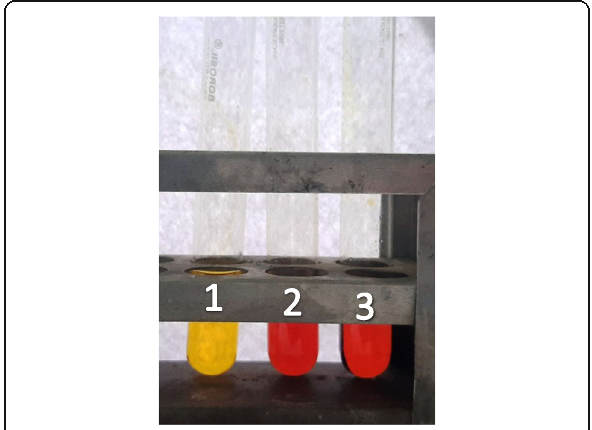
Fig. 7 Qualitative analysis of reducing sugar by DNS assay. Tube 1, blank; tube 2, 1st elution fraction (250 mM imidazole); tube 3, crude supernatant of cell